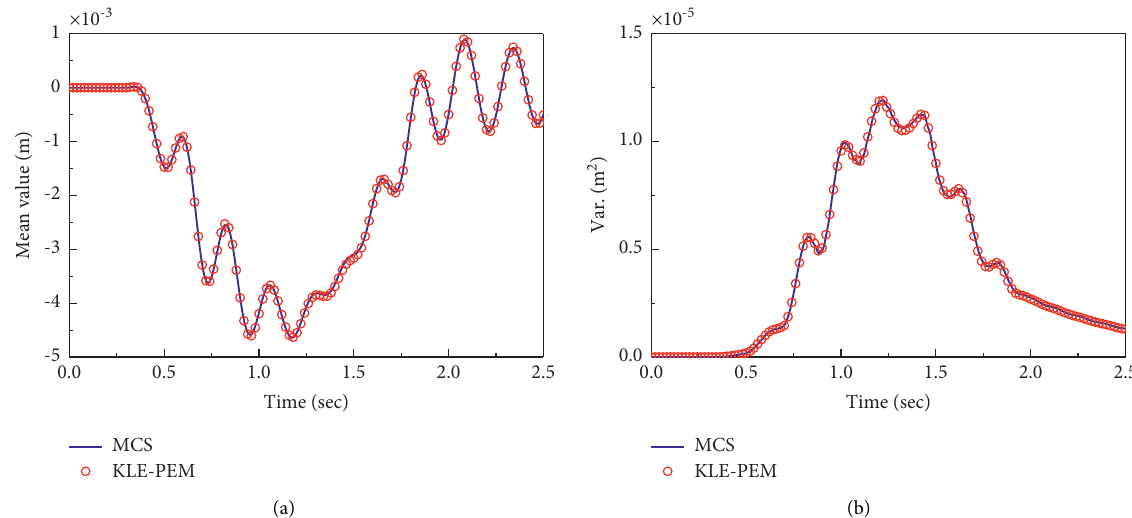
Figure 6: Comparison of the statistical moment of bridge midspan displacement of the two methods: (a) MEAN; (b) VAR.